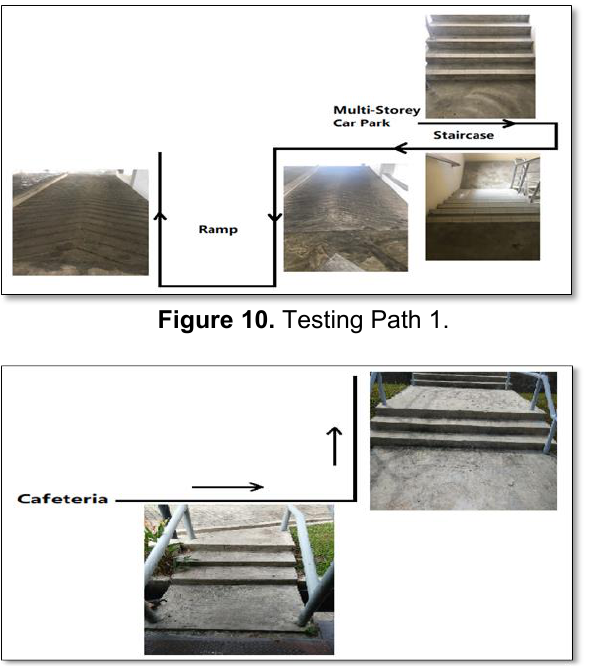
Figure 11. Testing Path 2.